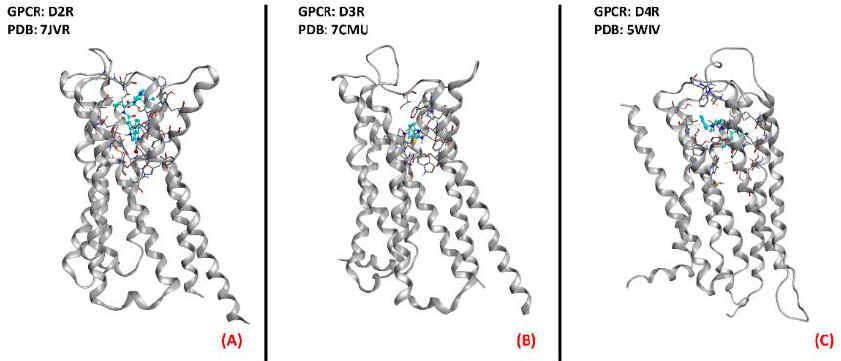
Figure 11. Representation of the three-dimensional structures of the dopamine receptors thatcould be considered for ALS treatment. ( A ) D2R (sourced the Protein Data Bank, PDB code: 7JVR [115], method: cryo-EM, resolution: 2.80 Å), ( B ) D3R (sourced from the Protein Data Bank, PDB code: 7CMU [116], method: cryo-EM, resolution: 3.00 Å ), and ( C ) D4R (sourced from the Protein Data Bank, PDB code: 5WIV [117], method: X-ray diffraction, resolution: 2.14 Å). All of the images were created and rendered with MOE.